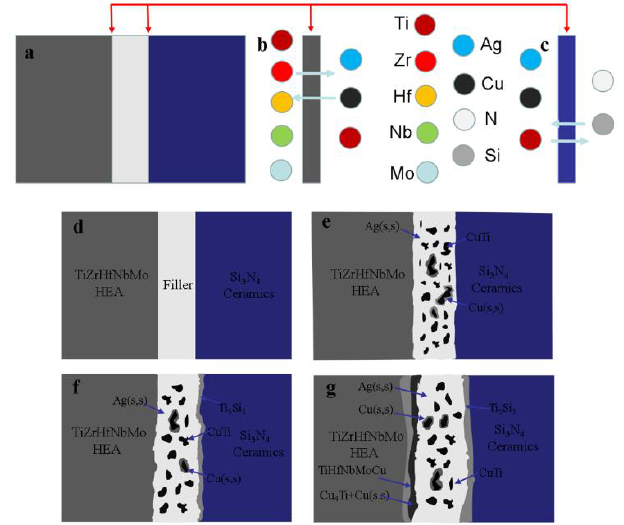
Figure 7. Schematic diagram of microstructural evolution of TiZrHfNbMo HEAs/Si 3 N 4 brazed joint. ( a ) Schematic diagram of brazing interfacial, ( b ) Interface between zone I and zone III, ( c ) Interface between zone I and zone II, ( d ) Brazing assembly diagram, ( e – g ) Atom diffusion and phase generate during brazing.